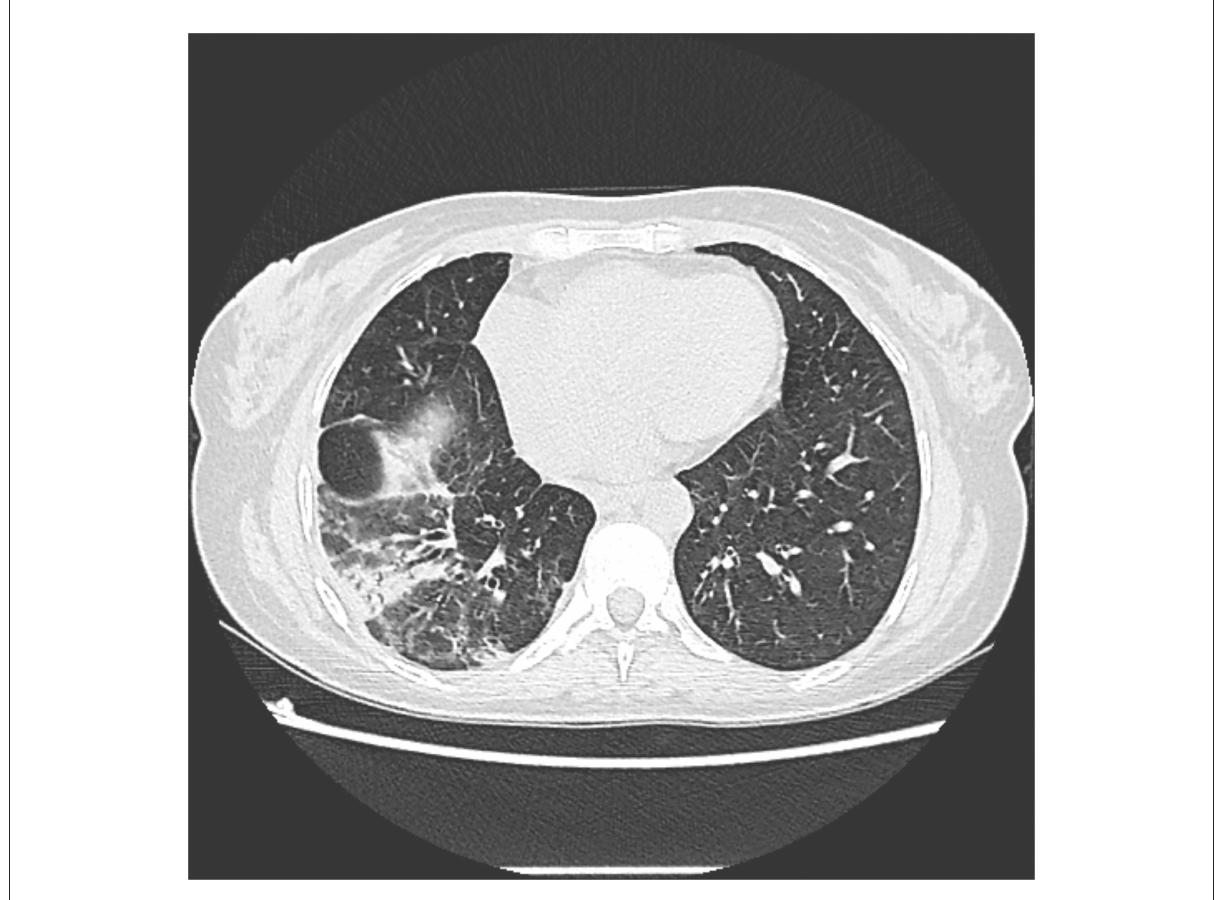
FIGURE4 Slice of CT scan showing parenchymal fibrosis and bronchiectasis in the right lower lobe.